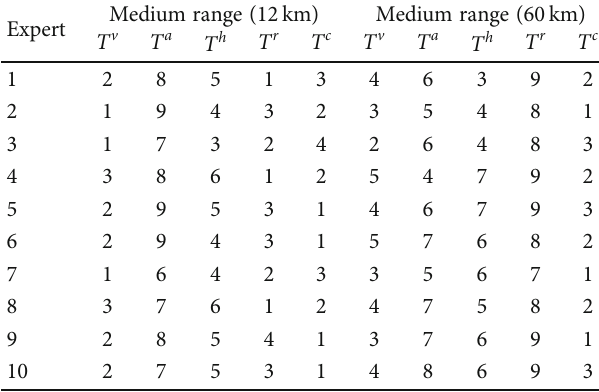
Table 2: Expert opinion evaluation form in medium-range air combat mode.